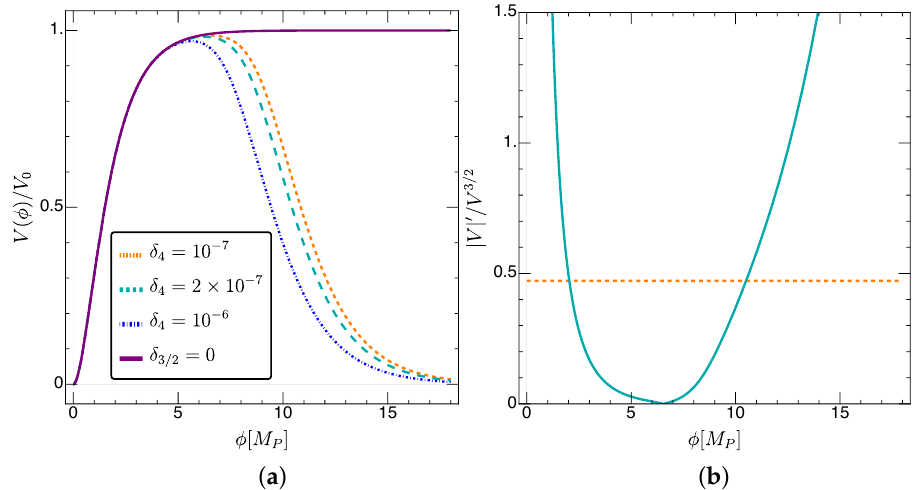
Figure 2. ( a ) The R 4 model effective potential. The yellow line corresponds to the δ 4 = 0 limit of Starobinsky inflation. Non-zero δ 4 introduces a right branch of the inflationary potential (blue curve). In such cases, the slow roll may be realized in both directions. ( b ) Plot of the first of the conditions (1). Eternal inflation does not dominate large field values. It can only occur around the top of the hill. However, this effect is unstable: quantum fluctuations cannot “keep” the rolling around the maximum for an arbitrarily long